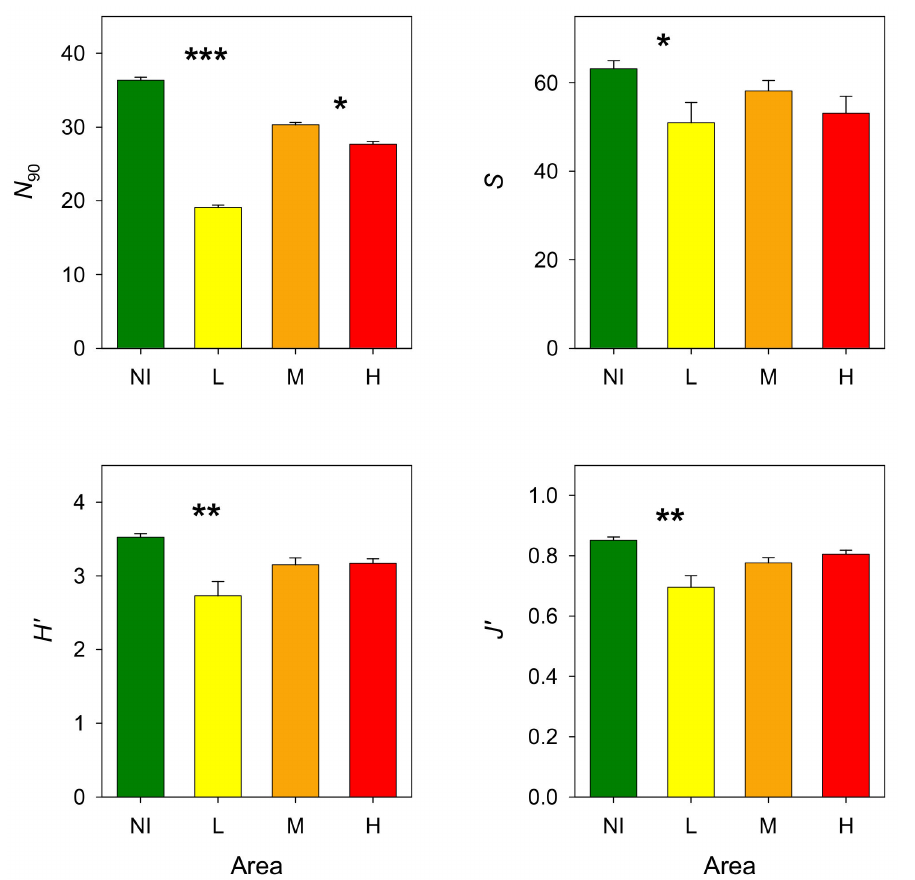
Figure 6. Mean values and standard errors of N 90 , Species Richness ( S ), Shannon ( H (cid:48) ), and Pielou’s evenness ( J (cid:48) ) diversity indices, estimated from beam trawl samples in the four areas considered: Non-impacted (NI), Low effort history (L), Medium effort history (M), and High effort (H). p -values of the Student’s t -test to test for differences between areas are presented: * p < 0.05; ** p < 0.01; *** p <